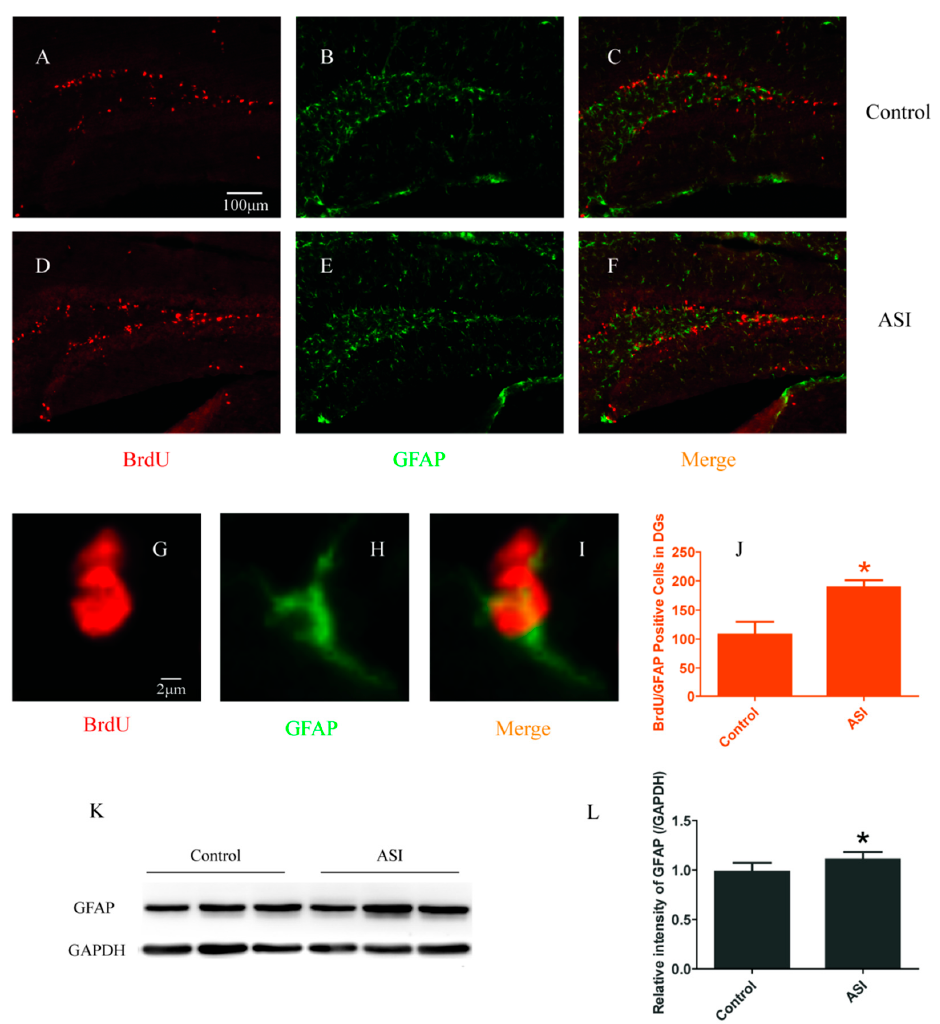
Figure 2. ASI (25 mg/kg) increased the total number of proliferative radial glia-like cells (BrdU + /GFAP + ). ( A – I ) Confocal images of BrdU (red) and GFAP (green) immunostaining: ( A – C ) Control group; ( D – F ) ASI group; and ( G – I ) enlarged images of the cells from ASI group. ( A – F ) Scale bar = 100 μ m. ( G – I ) Scale bar = 2 μ m. ( J ) Quantification of BrdU + /GFAP + double immunopositive cells in two groups ( n = 4/group). ( K ) Western blotting analysis of GFAP in hippocampus. ( L ) Gray intensity analysis of GFAP in hippocampus ( n = 8/group). * p < 0.05. The data are presented as mean ± SD.